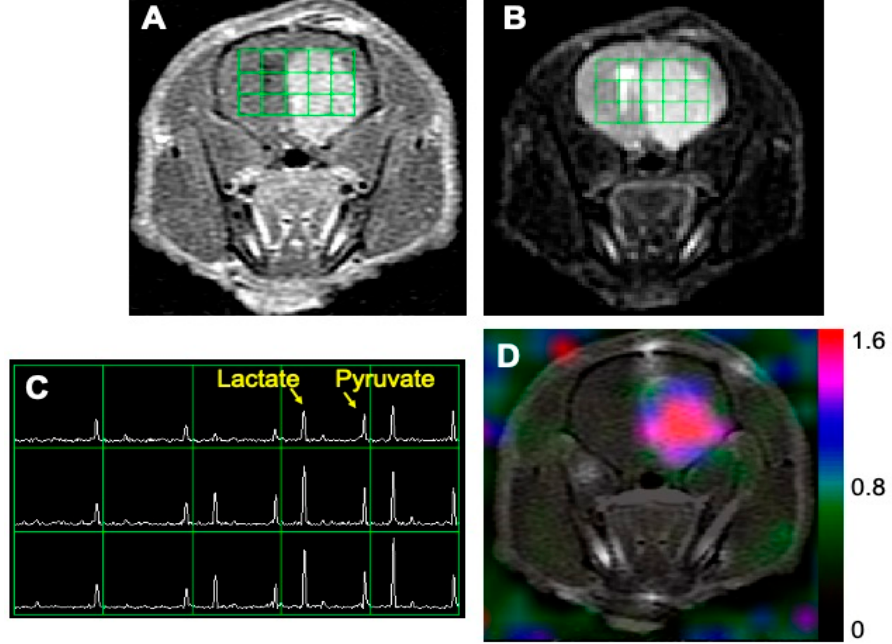
Figure 1. An example of MR imaging data from a rat model of glioblastoma. A post-gadolinium T1-weighted image ( A ) and T2-weighted image ( B ) showed the typical features of a high-grade glioma: contrast enhancement in the post-contrast T1-weighted image and hyperintensity in the T2-weighted image. The grid in ( A , B ) represents the array of 13 C spectroscopic imaging data over the brain, with an in-plane voxel resolution of 2 × 2 mm ( C ). Each voxel in ( C ) contains the hyperpolarized 13 C pyruvate signal and its metabolic product, lactate. The color overlay map of the ratio of lactate to pyruvate in ( D ) shows a highly elevated level of lactate in the enhancing lesion.